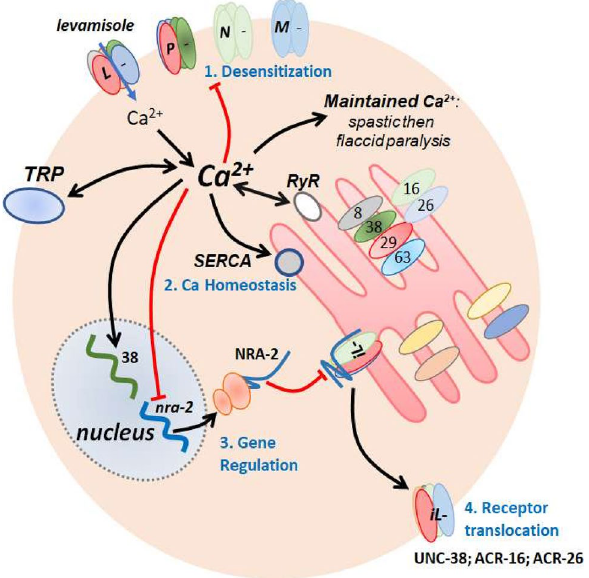
Figure 10. Summary diagram of proposed mechanisms of homeostatic plasticity allowing levamisole habituation. Levamisole preferentially opens the L -subtype of AChRs, to produce depolarization and entry of calcium. The calcium influx in the muscle produces contraction and spastic paralysis. The L -subtype of AChRs desensitizes over ~ 20 min ( 1: Desensitization). Calcium also builds up in the cell with the support of the calcium-induced calcium release via the ryanodine receptor (RyR). The sarcoplasmic calcium then gradually decreases due to homeostatic uptake mechanisms ( 2: Ca Homeostasis) that include the sarcoplasmic endoplasmic reticulum calcium ATPase (SERCA). unc-38 is upregulated while nra-2 is down regulated ( 3: Gene Regulation) that leads to a dis-inhibition of insensitive levamisole AChRs ( iL- ) in the ER containing UNC-38, ACR-26 and ACR-16 ( 4: Receptor translocation). The iLs are then translocated to the membrane facilitation the recovery of motility of the